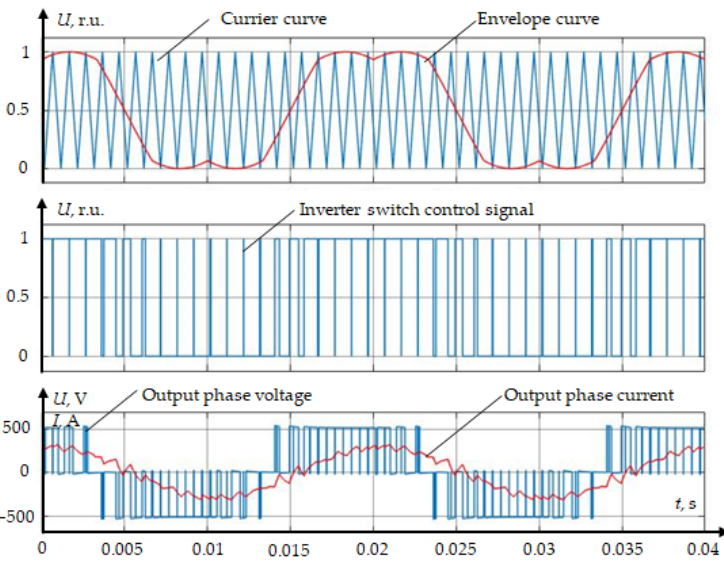
Figure 7. Simulation results at 0 electrical degrees angle of connection ( T = 60 °C and below)